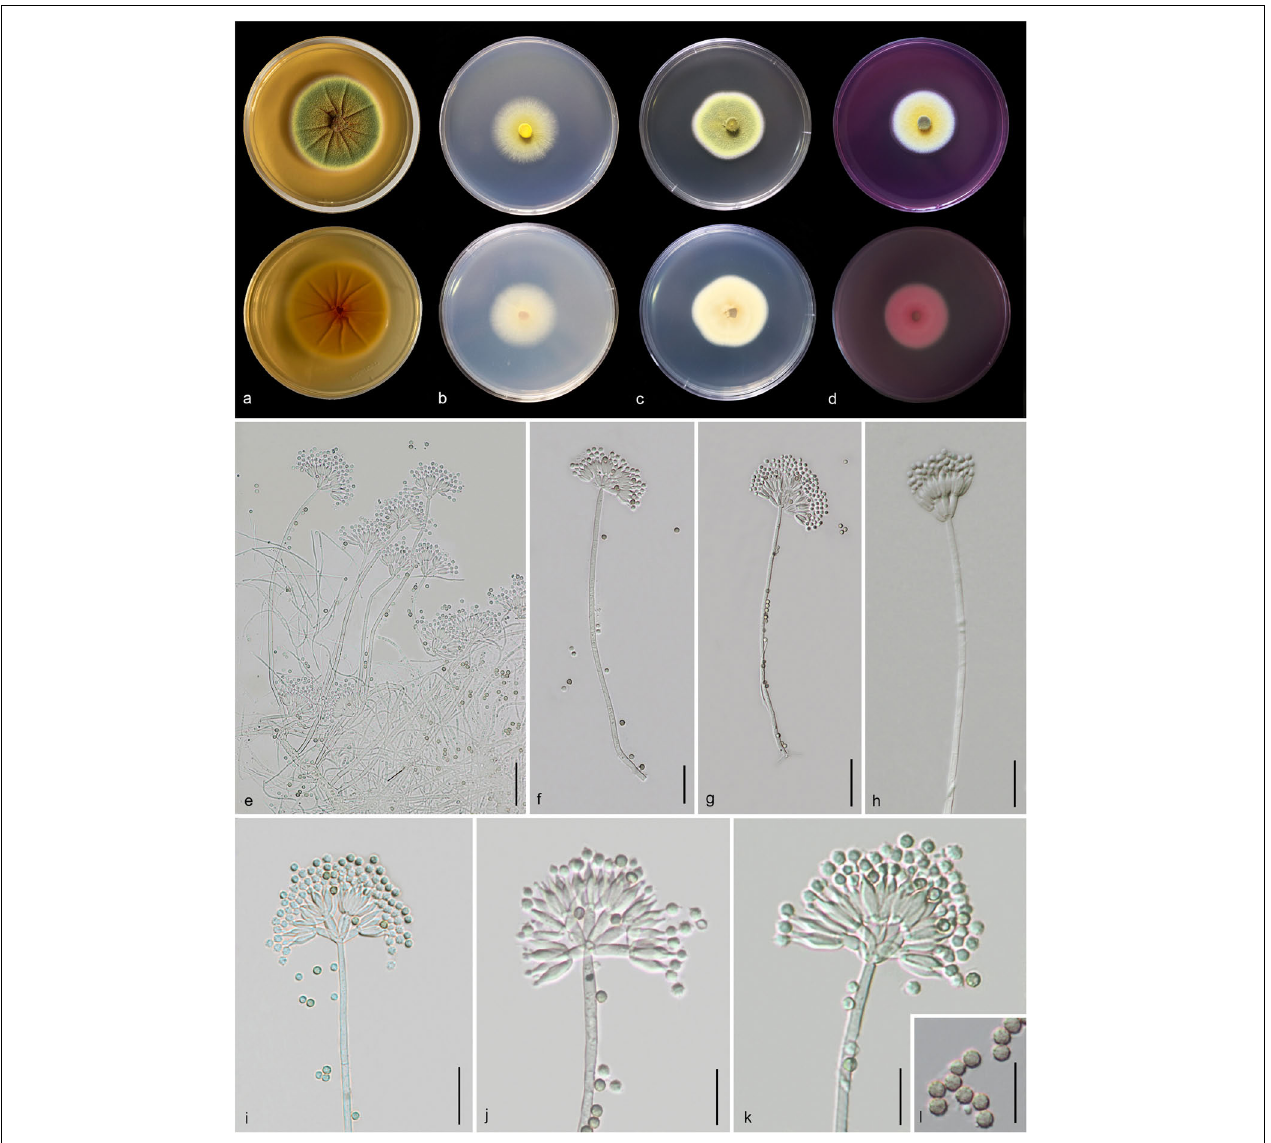
FIGURE 14 | Talaromyces yunnanensis (MFLU 20-0434, holotype). (a–d) Colonies on MEA, CYA, PDA and rosebengal at 25 ◦ C, respectively. (e–h) Conidiophores and conidia. (i–k) Close-up of conidiophores and conidia. (l) Conidia. Scale bars: (e,g) = 30 µ m, (f,h,i) = 20 µ m, (j–l) = 5 µ